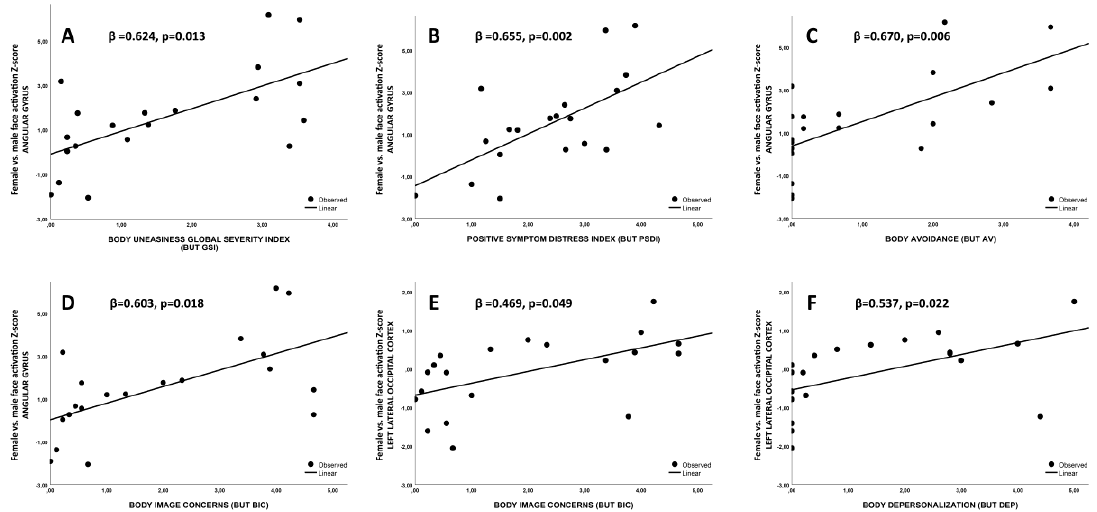
Figure 6. ( A )–( D ) Association between angular gyrus ROI Z-scores with body uneasiness test related scales; ( E , F ) association between left lateral occipital cortex Z-score with body uneasiness test scales. ROI = region of interest.